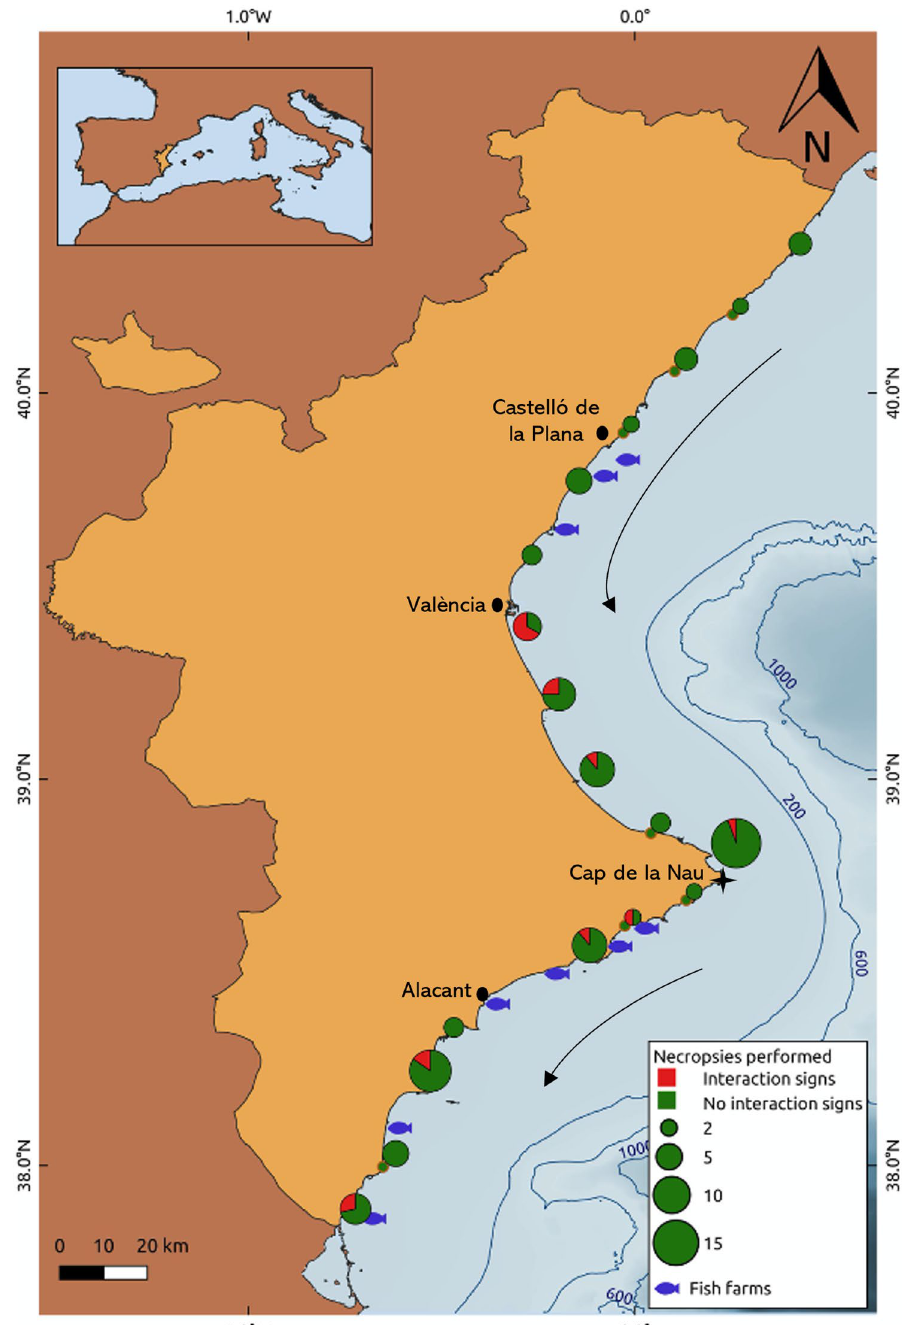
Figure 3. Stranding cases and fish farm locations. Necropsies performed every 25 km on well preserved striped dolphins (n = 105) during the study period. Individuals dead by traumatic interaction are represented in red (right). Black arrows show main sea superficial